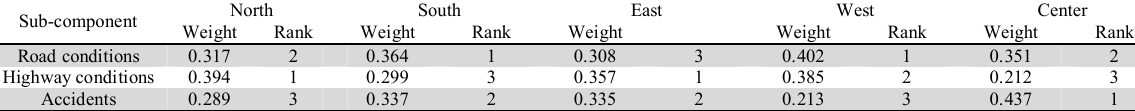
The summary of ranking of regional factors based on ANP method